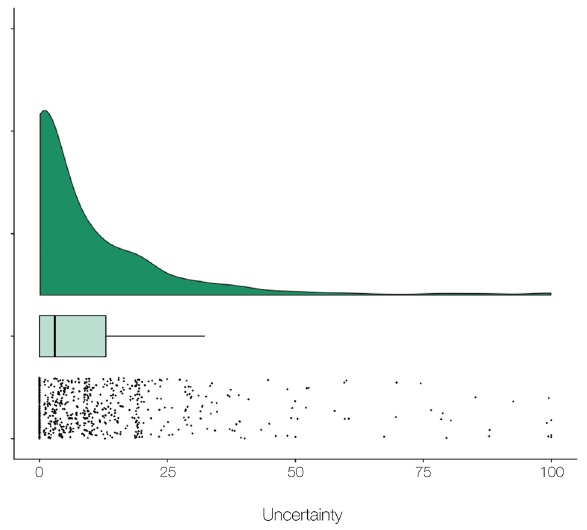
Figure 2. Distribution of uncertainty. This figure depicts uncertainty ratings across participants, smoothed via a kernel density function (top) and depicted as raw ratings (below). Uncertainty was present during the task ( M uncertainty = 9.48, SD uncertainty = 15.63); however, the scores were zero-inflated confirmed via a zero-inflation score ˜ β test based on a χ 1 2 distribution ( S ( ) = 4,145,914, p < 0.001. We therefore used a two-part model to account for zero-inflated data (see Fig.